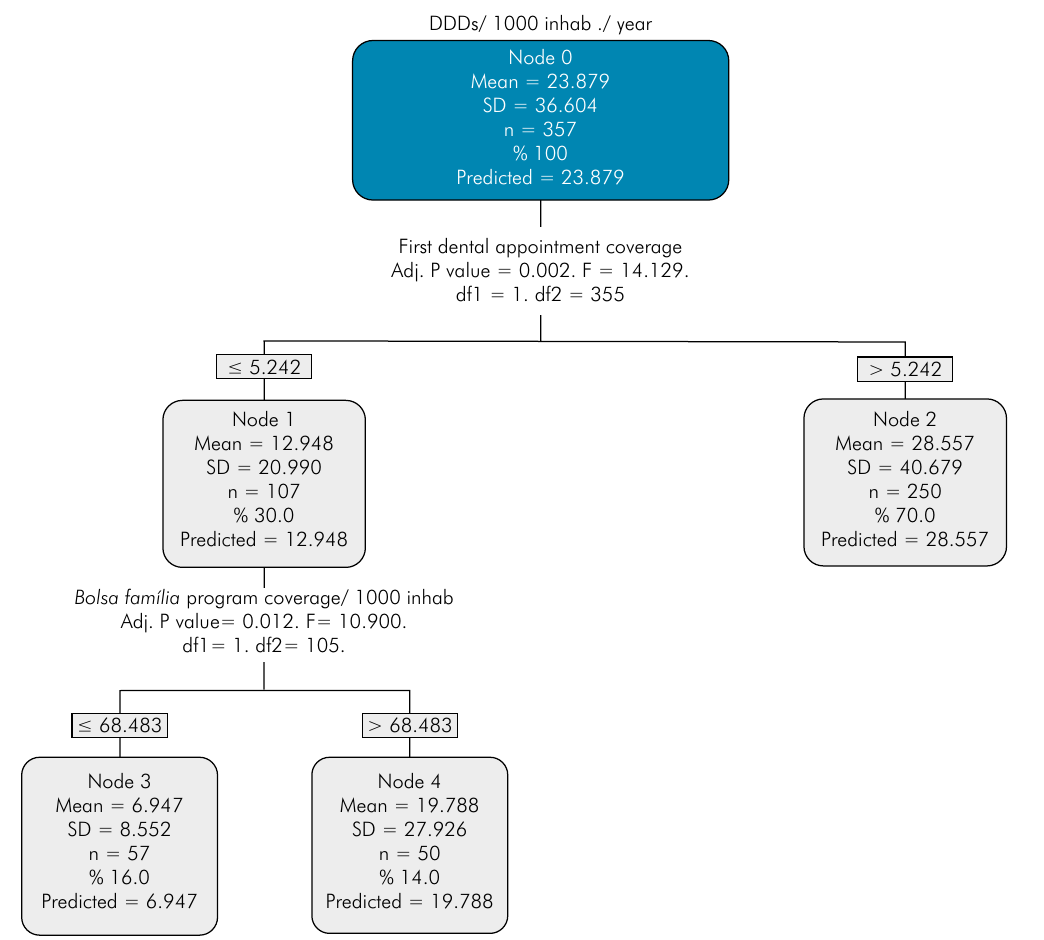
Figure 2. CART analysis for